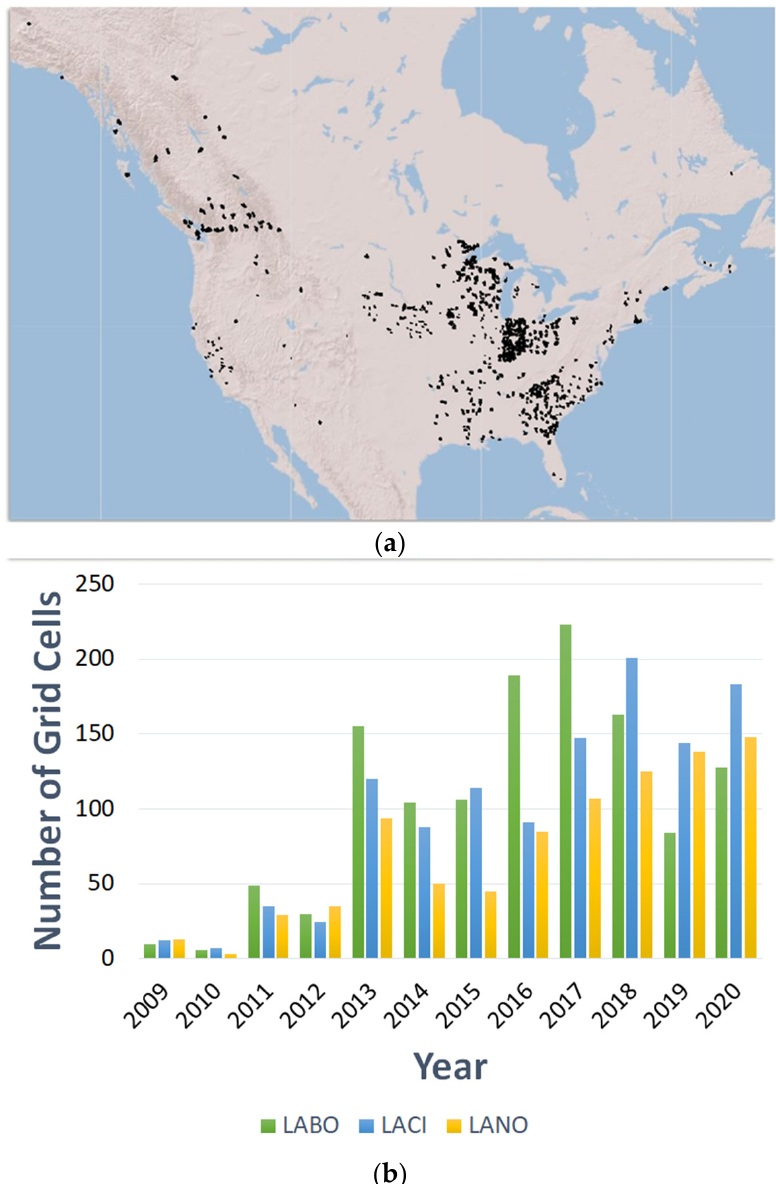
Figure 4. Mobile acoustic surveys have been conducted in more than 2000 grid cells across North America, represented in black ( a ), from 2009 through 2020 ( b ). From 2020 surveys, 128 cells contain data for eastern red bats (LABO), 179 cells contain data for hoary bats (LACI), and 145 cells contain data for silver-haired bats (LANO) [25]. Note: this is not a presence/absence map. Data and maps are adapted from the North American Bat Monitoring Program Partner Portal [26].